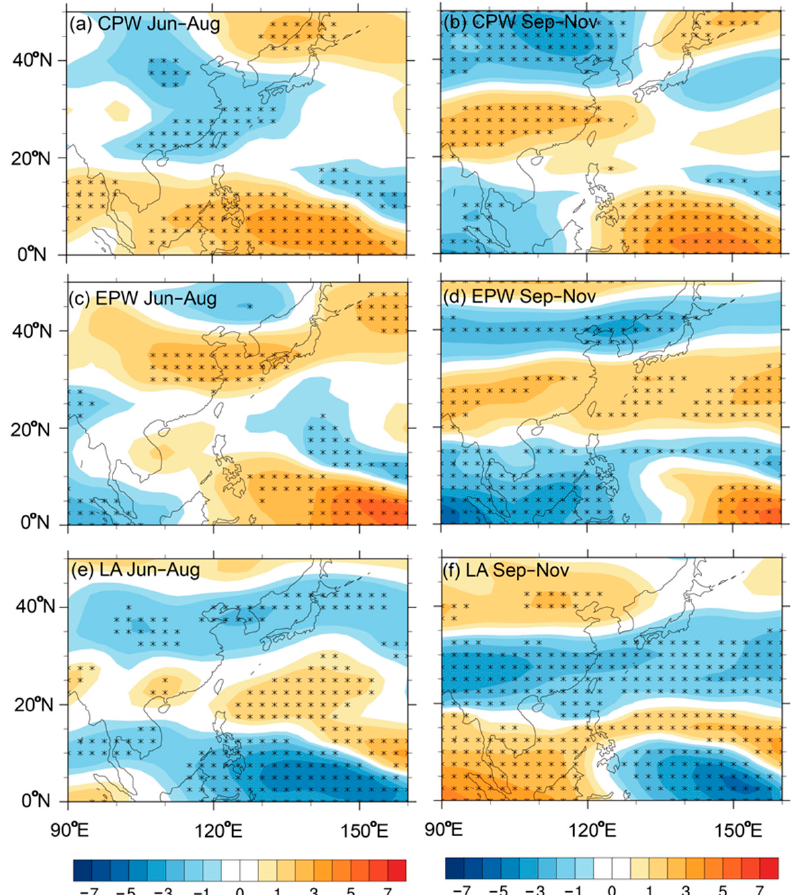
Figure 11. Composite anomalies of the vertical wind shear (VWS, m/s) for JJA ( a , c , e ) and SON ( b , d , f ) seasons during CPW ( a , b ), EPW ( c , d ) and LA ( e , f ) events. Regions with trends that are significant at 90% confidence are shaded by dots.